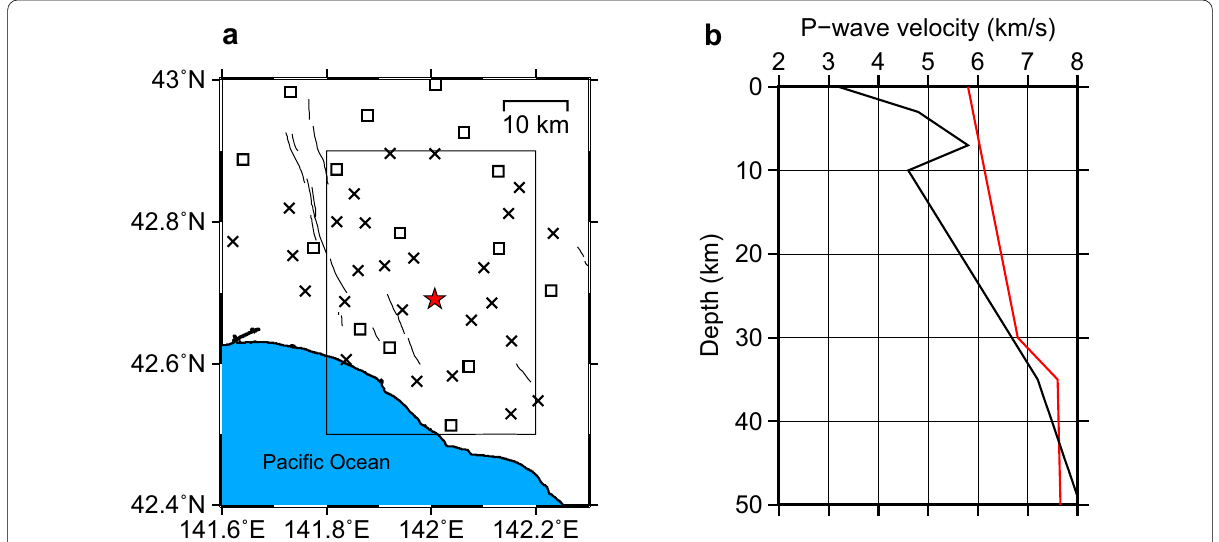
Fig. 2 a Seismic stations used in this study. Temporary and permanent stations are shown in crosses and in squares, respectively. A red star indicates the epicenter of the main shock of the 2018 Hokkaido Eastern Iburi earthquake. A rectangle indicates an area shown in Figs. 3, 4, 5. Thin solid lines are active faults (Research Group for Active Faults in Japan 1991). b P wave velocity structures. A red line is based on Kasahara et al (1994) and a black line is based on Iwasaki et al (2004) and Katsumata et al